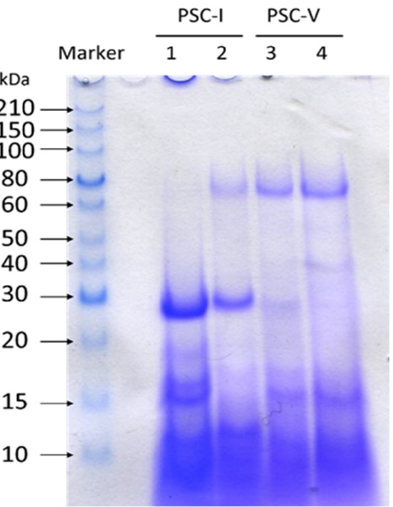
Figure 2. Molecular distributions of collagen peptides isolated from the skin of shortbill spearfish and striped marlin. Lane 1, type I collagen peptide of shortbill spearfish; Lane 2, type I collagen peptide of striped marlin; Lane 3, type V collagen peptide of shortbill spearfish; Lane 4, type V collagen peptide of striped